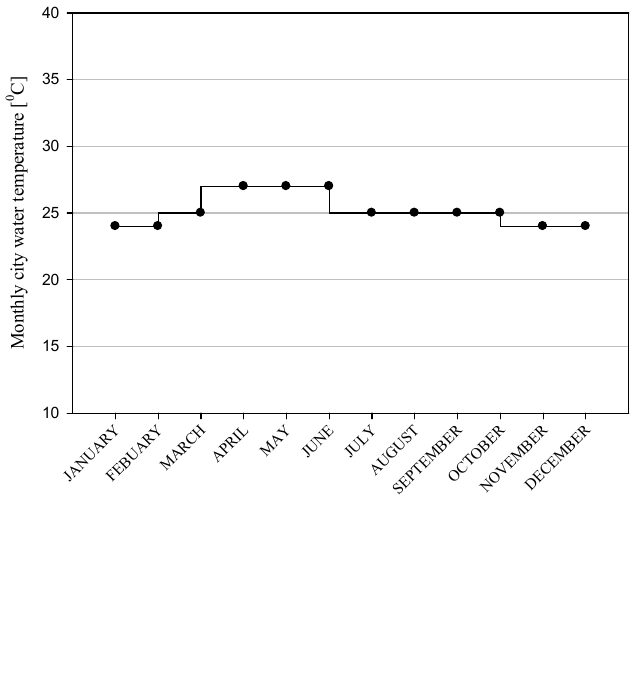
Figure 6. Monthly city water temperature profile in